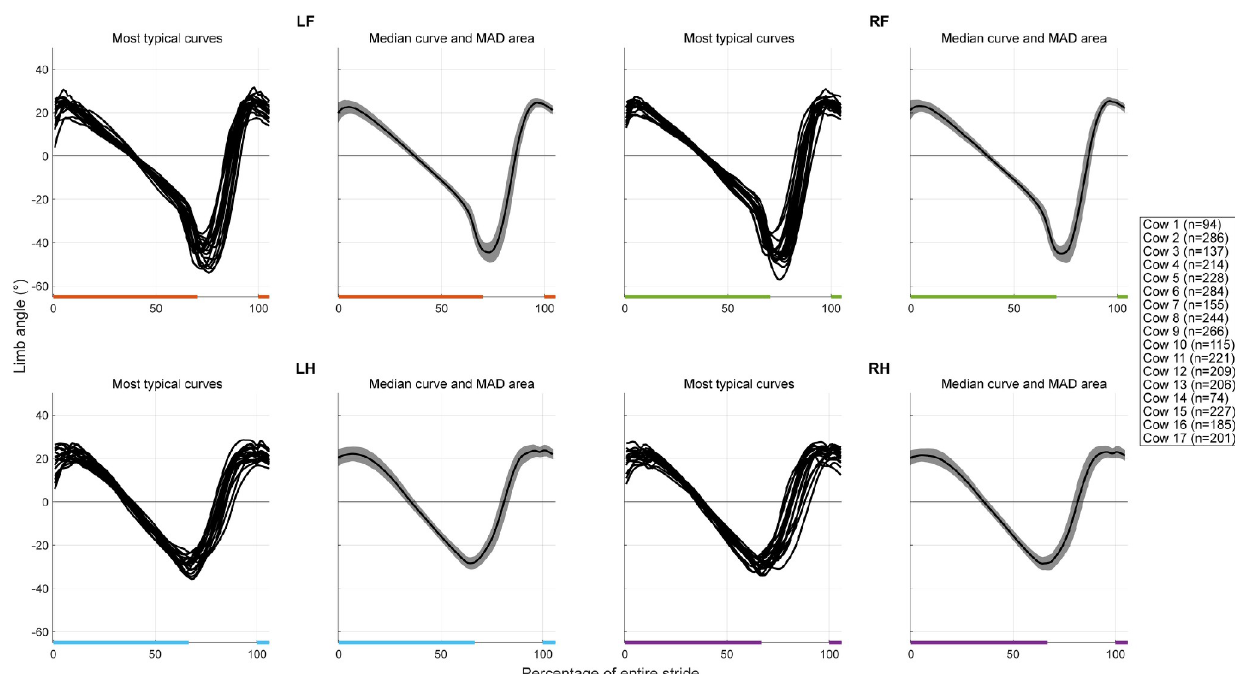
Fig 7. Distal limb angle curves per limb. For all limbs, the most typical curves per cow is shown on the left, and the median curve (black) with the MAD area (grey), calculated over all cows and steps, is shown on the right. The curves are shown on a scale from zero to 100% of the entire stride duration. The stance phases are indicated for every limb by the horizontal lines underneath the curves (orange: LF, green: RF, blue: LH, purple: